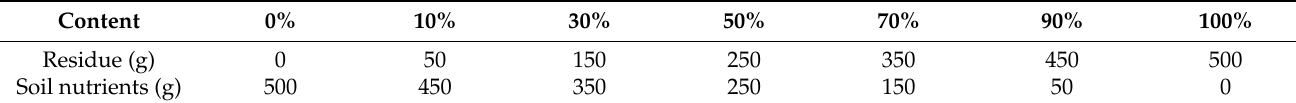
Table 3. Mass ratios of residues and soil nutrients.